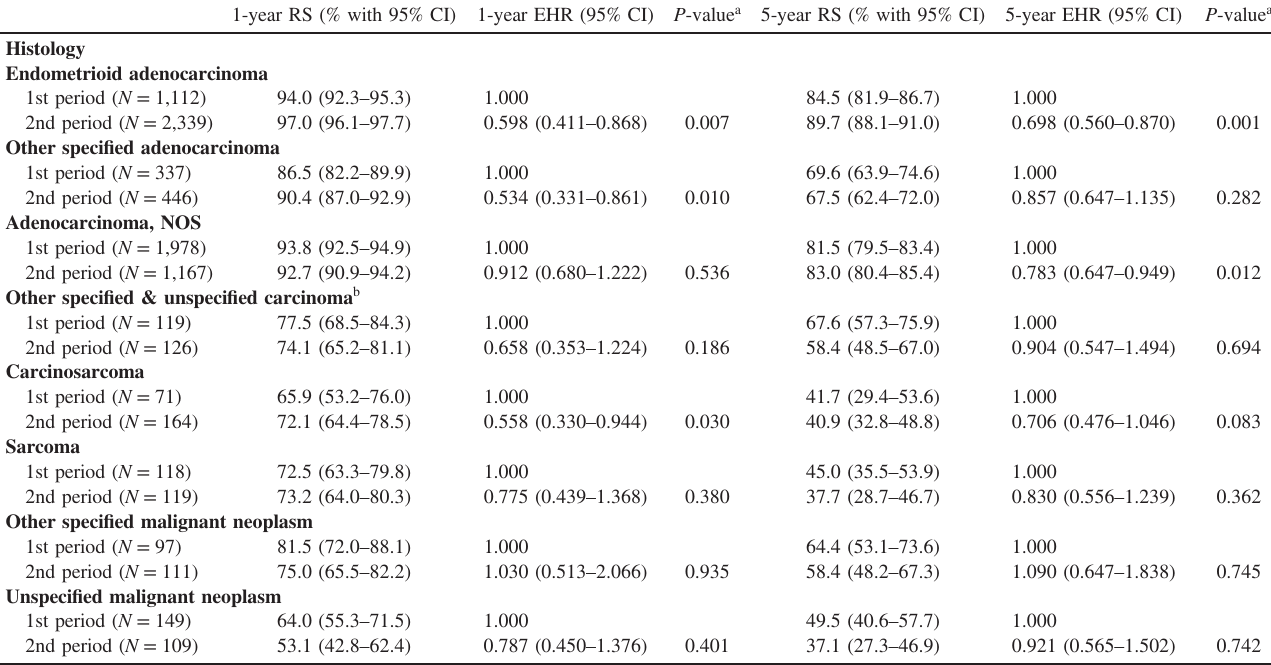
Table 3. Relative survival rates and estimated excess hazard ratios by histology, 1st period (1993 – 2000) and 2nd period (2001 – 2006)